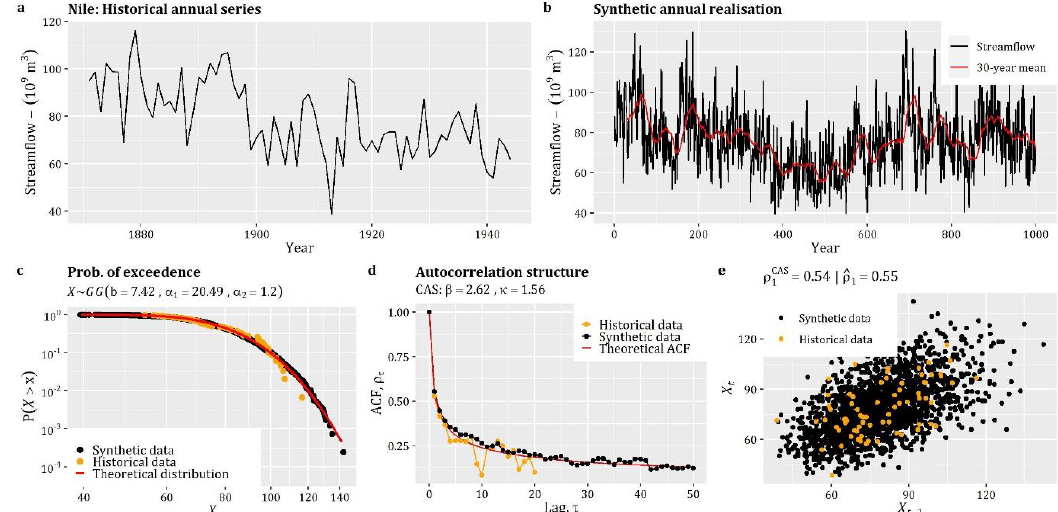
Figure 12. ( a ) Historical annual time series of Nile streamflow at Aswan Dam; ( b ) synthetic time series (1000 years); ( c ) empirical, simulated, and theoretical distribution function, with the parameters of the theoretical distribution given in the title of the plot; ( d ) empirical, simulated, and theoretical and autocorrelation coefficients, with the parameters of CAS given in the title of the plot; and ( e ) scatter plot of annual historical and synthetic time series for time lag 1.